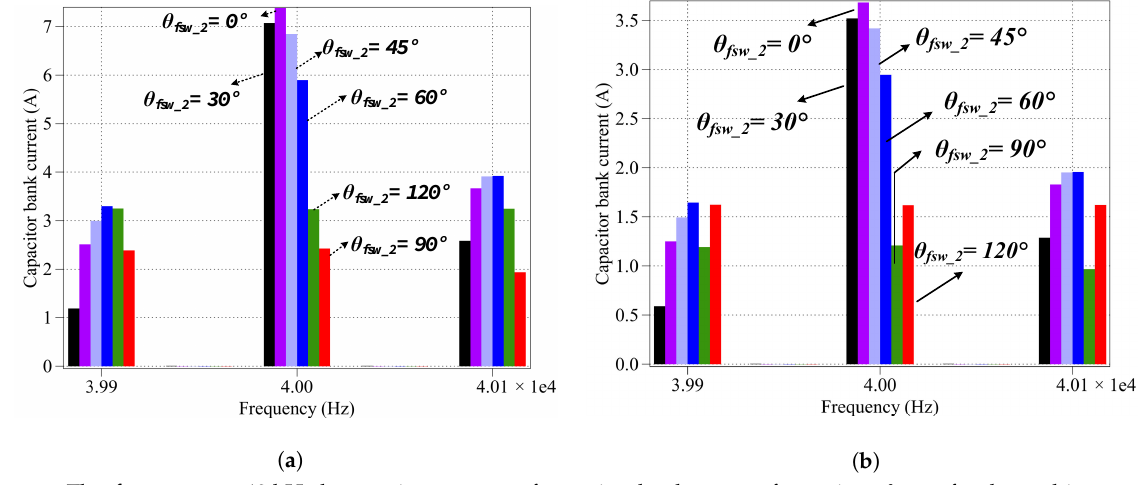
Figure 6. The f sw _ harmonic = 40 kHz harmonic spectrum of capacitor bank current for various θ fsw _2 for the multi-converter system with: ( a ) common DC-bank, and ( b ) individual DC-banks—both at rated operating conditions.